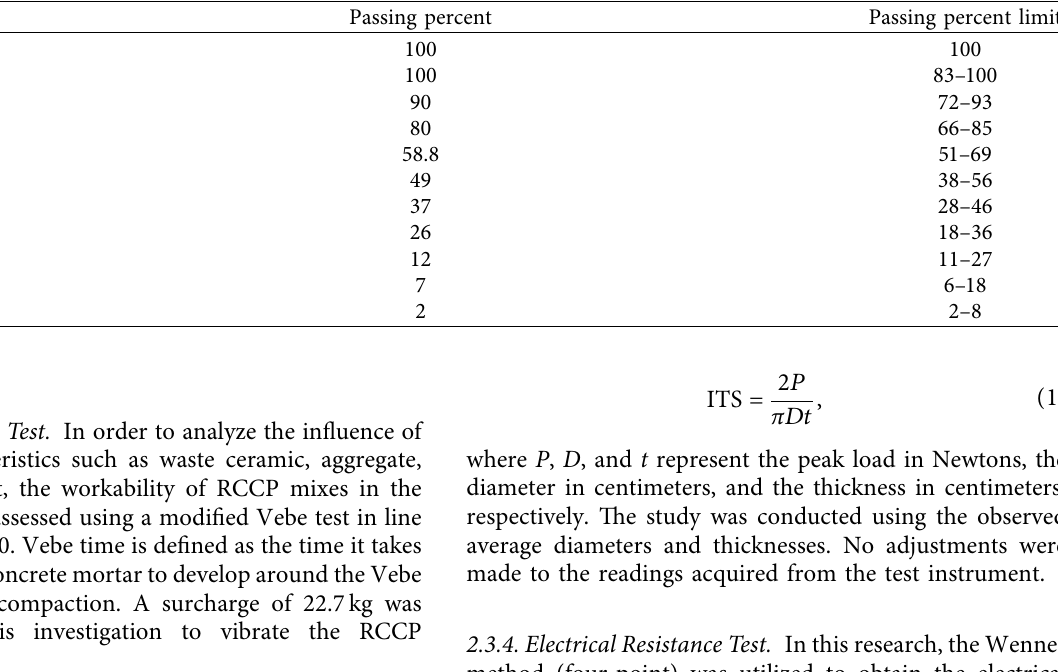
Table 5: Te aggregate gradation used in this